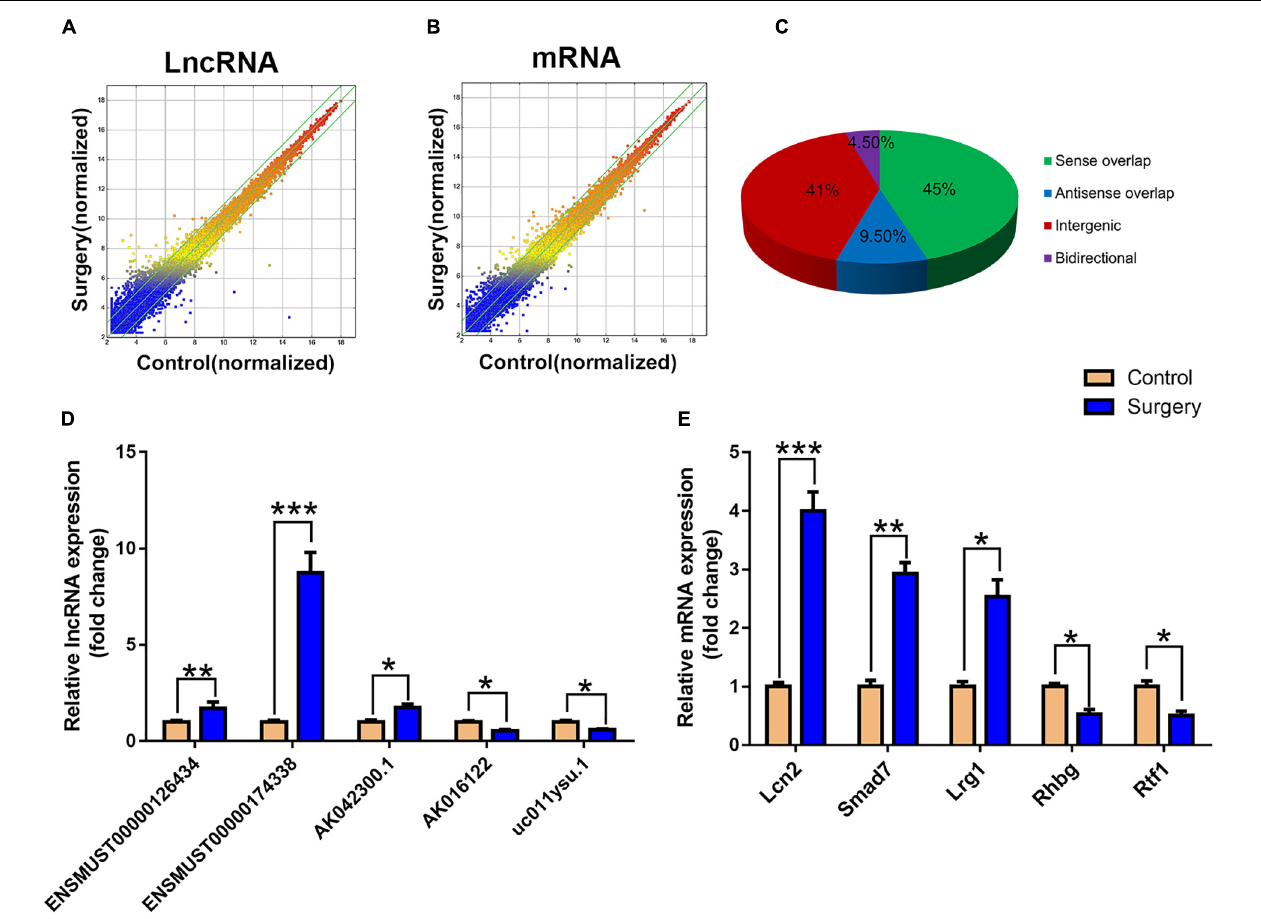
FIGURE 3 | LncRNA and mRNA expression profiles. (A) The scatterplots of lncRNA expression profiles. (B) The scatterplots of mRNA expression profiles. The scatterplots of lncRNA and mRNA were used to assess the lncRNA and mRNA expression variations between the surgery group and the control group. The green lines represent the fold change (the default value is 2 times). (C) Subgroup analysis of differentially expressed lncRNAs was based on their gene mapping and the relationships between adjacent protein-encoding genes. (D) Relative expression of five lncRNAs. (E) Relative expression of five mRNAs. Data are presented as means ± SEM; ∗ P < 0.05, ∗∗ P < 0.01, ∗∗∗ P < 0.001, vs. Control, Student’s t -test, N = 10 for all